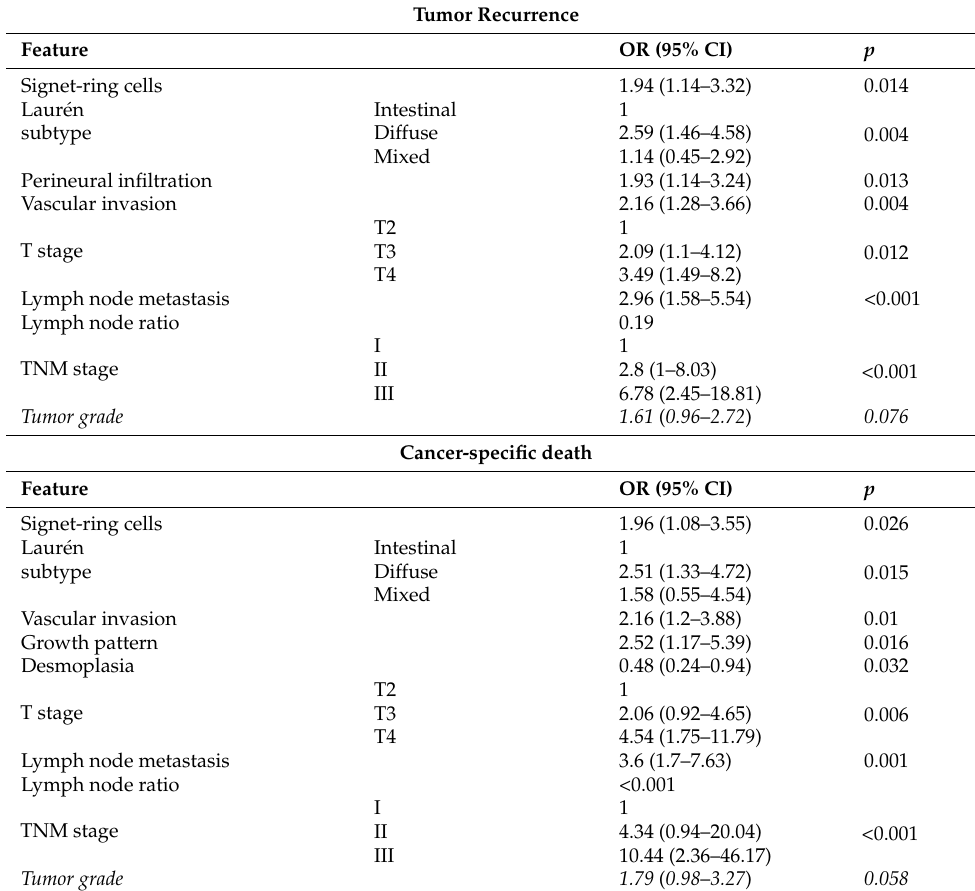
Table 3. Univariate analysis. Features significantly related to tumor recurrence and death.